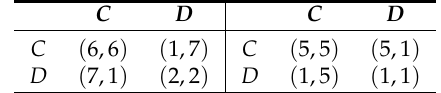
Table 2. Utilities for PD (left) and SG (right) in Example